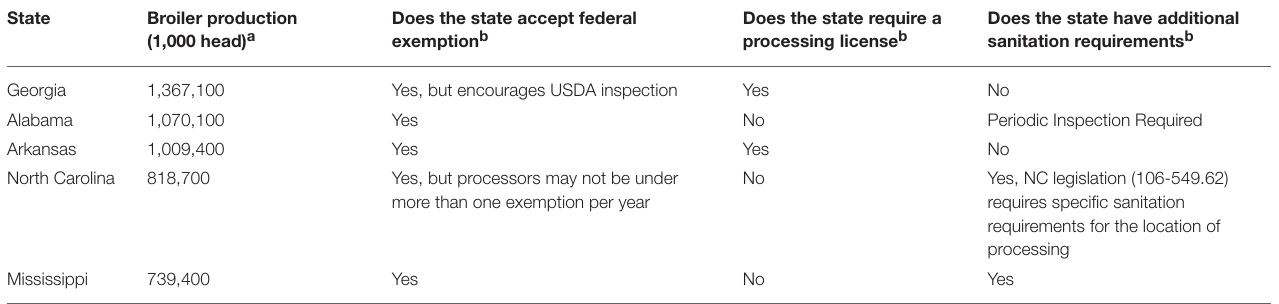
TABLE 2 | State regulations of Mobile Poultry Processing